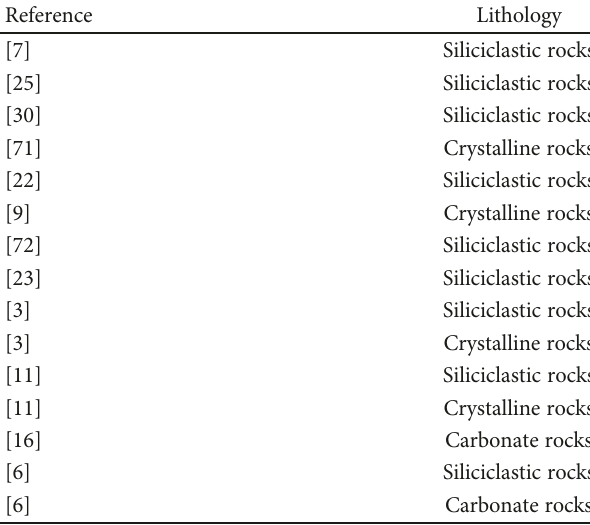
Table 3: A list of the references used for the plot in Figure 13(c).